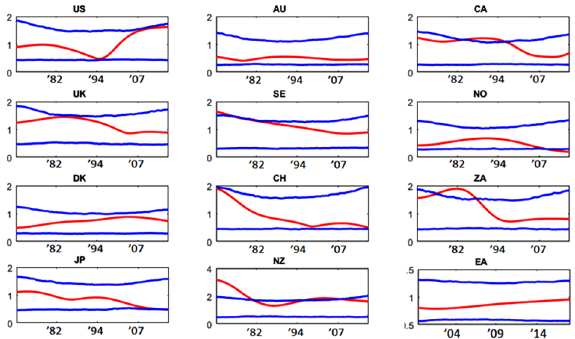
Note : The number of bootstrap samples: 1,000. The plot for the euro area starts from 3Q 1997. Figure 7. Estimates of the wavelet gain coefficients for house prices with respect to bank credit – mean values in the interval of 8-16 years and their constancy tests in 1970–2016 (source: own